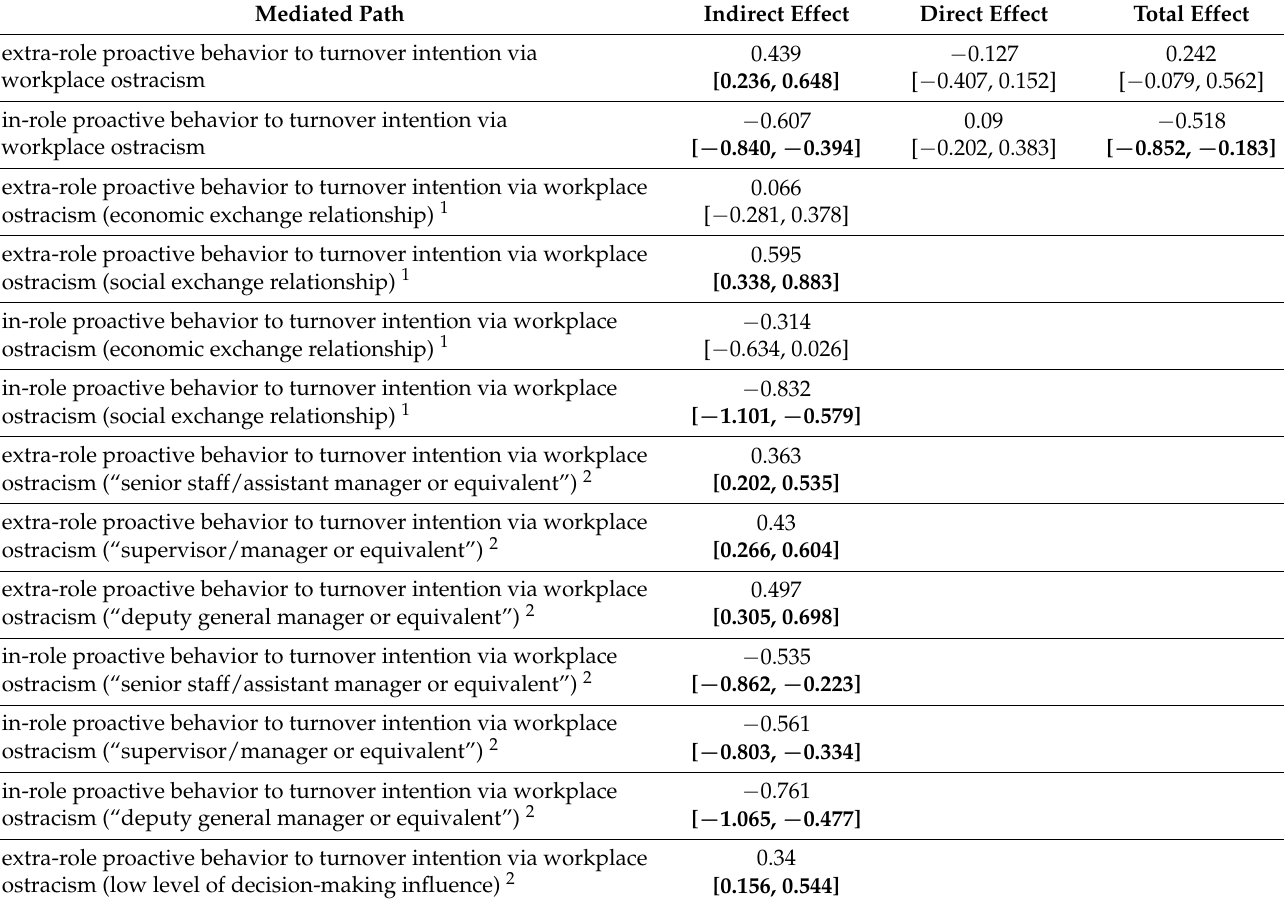
Table 4. Summary of indirect effects using bootstrapping